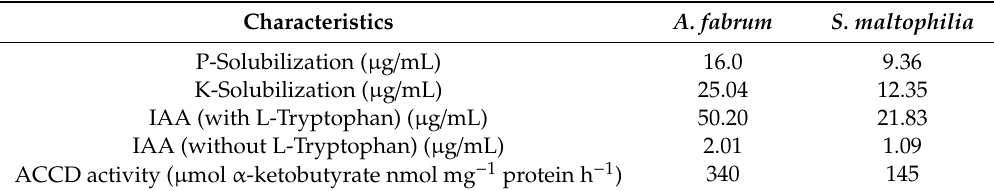
Table 2. Characteristics of plant growth-promoting